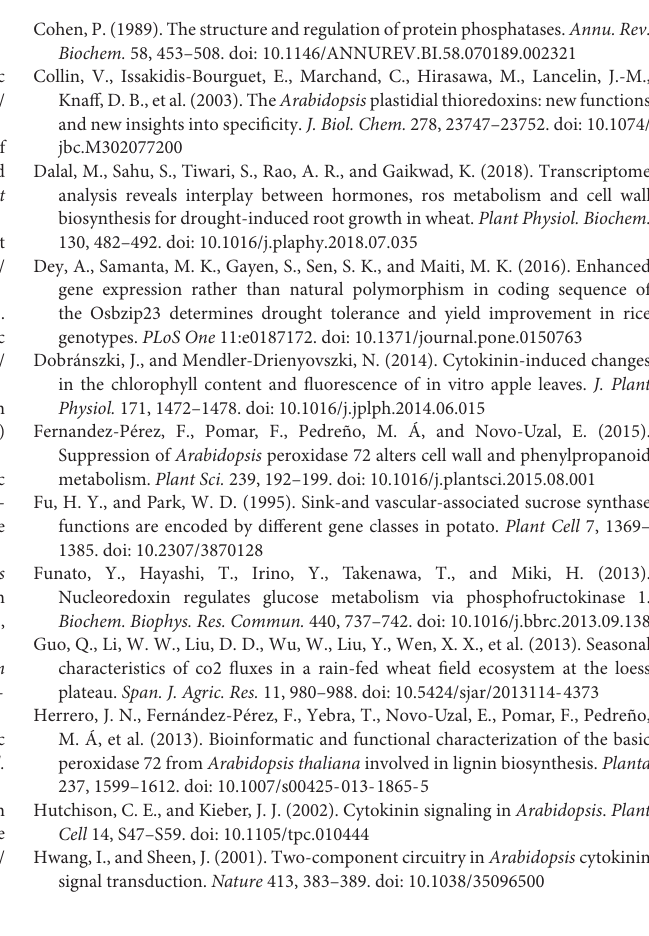
Supplementary Figure 4 | The bar graph of WT, TaNRX1 overexpression and RNA interference wheat lines differentially expressed genes after PEG6000